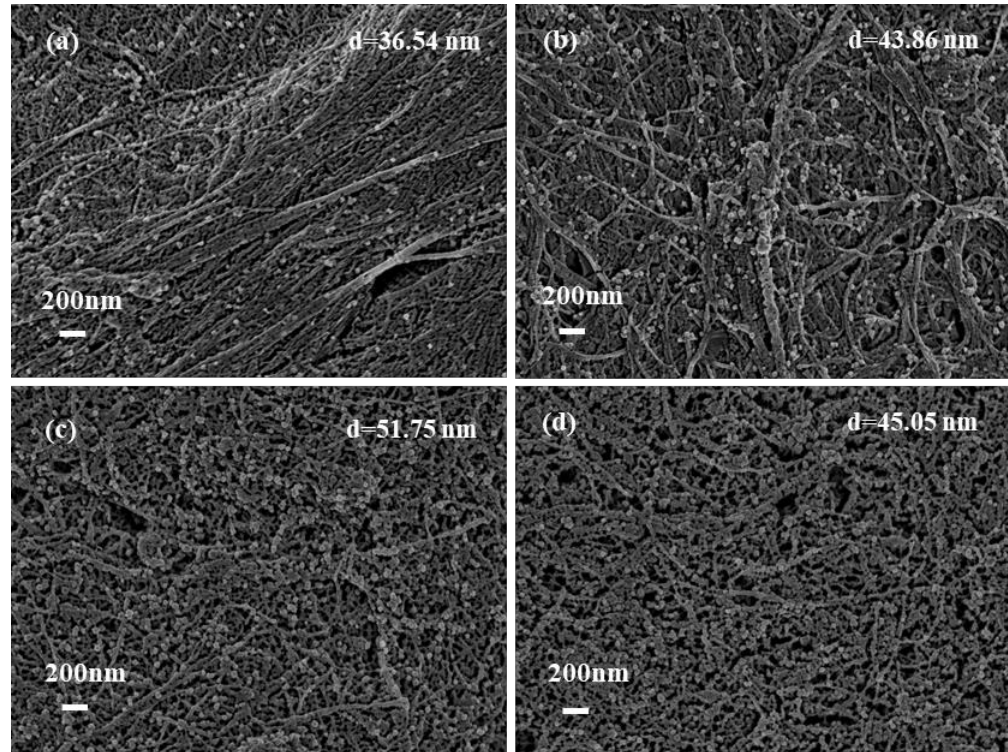
Figure 5. The SEM images (a – d) of bhpFibers@AgNP-based paper prepared by 0.2 mg/mL DLA and